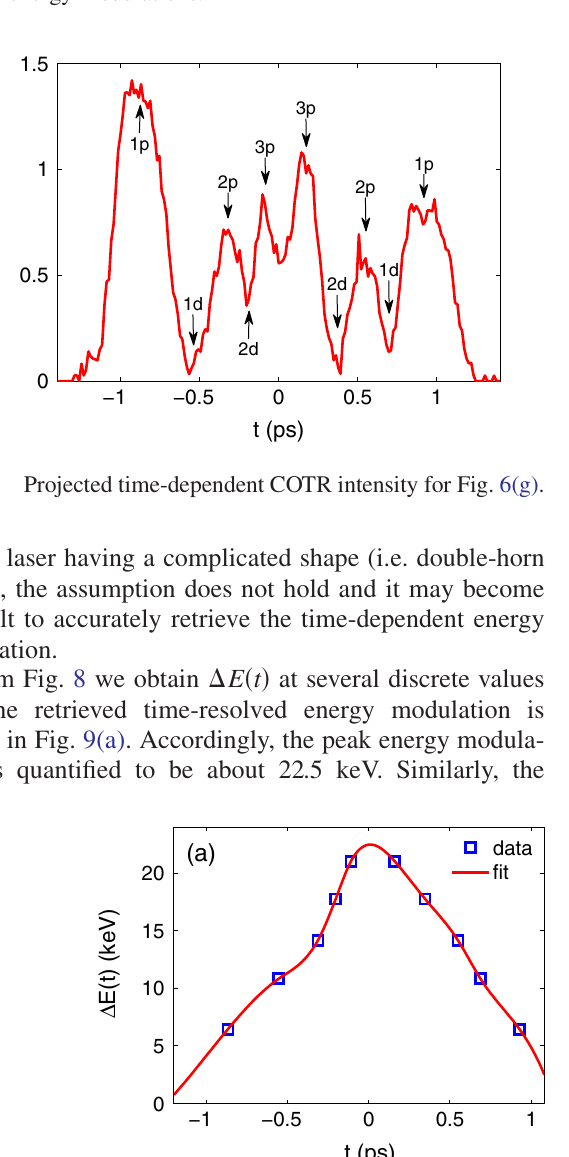
FIG. 9. (a) Reconstructed time-dependent energy modulation; (b) reconstructed temporal profile for the 1590 nm laser.